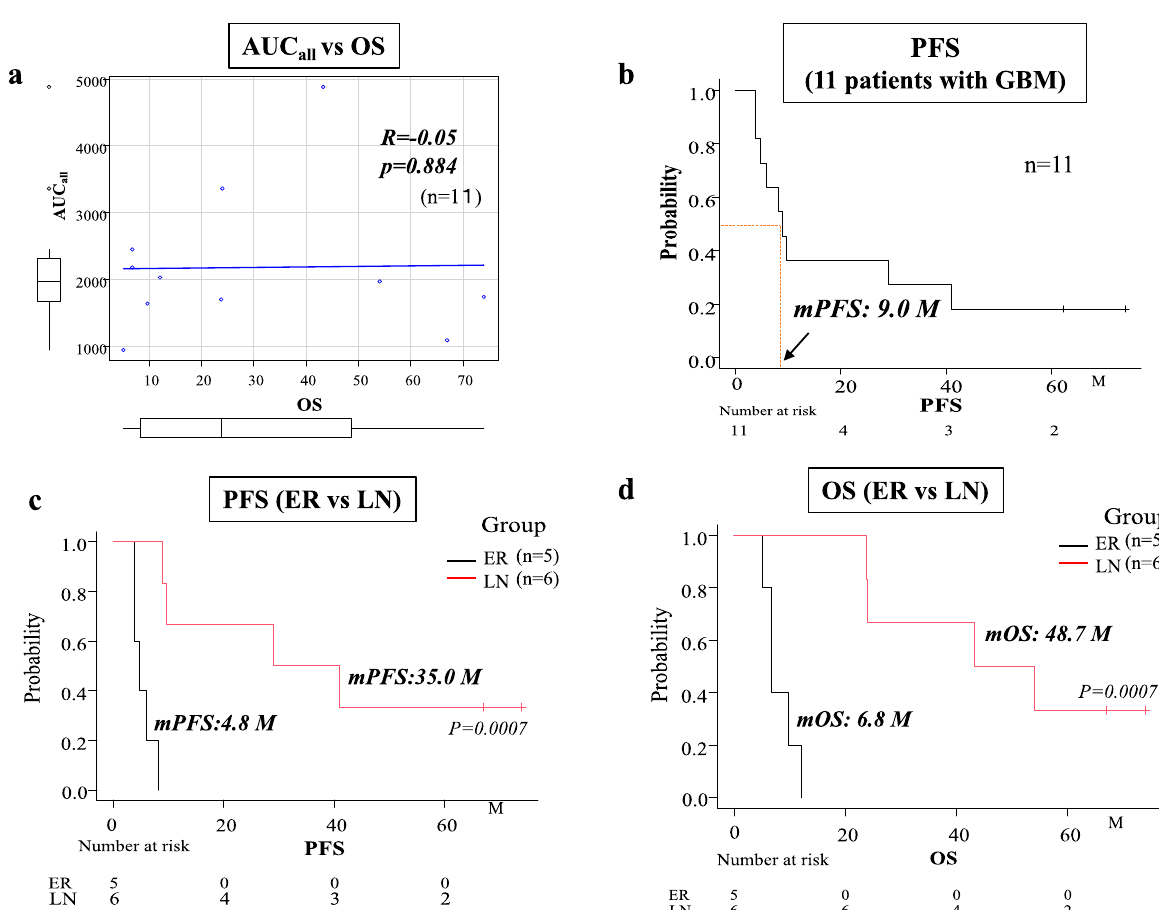
Figure 2. ( a ) Spearman’s regression analysis showing no correlation between total concentration (AUC all ) of BCNU and overall survival (OS) in 11 patients with GBM. ( b ) Kaplan–Meier survival curve showing progression-free survival (PFS) in 11 patients with GBM (the median PFS was 9 months). ( c , d ) Kaplan–Meier survival curves showing PFS ( c ) and OS ( d ) in the early recurrence (ER) group (five patients) and the late or no recurrence (LN) group (six patients). Patients with a median PFS < 9 months were classified in the ER group, whereas patients with a median PFS ≥ 9 months were included in the LN group. The median PFS of the ER group (4.8 months) was significantly shorter than that of the LN group (35.0 months) ( p = 0.0007). The median OS of the LN group (48.7 months) was significantly longer than that of the ER group (6.8 months) ( p = 0.0007). 3.4. Relationship between Total BCNU Concentration (AUC all ) and Tumor Control Cavity in Patients with or without BCNU The mean AUC all of BCNU concentrations in the LN group (2456.7 ± 1405.7 ng·day/mL) was greater than that in the ER group (1849 ± 522.4 ng·day/mL), but the difference between these two groups was not significant ( p = 0.393) (Figure 3).